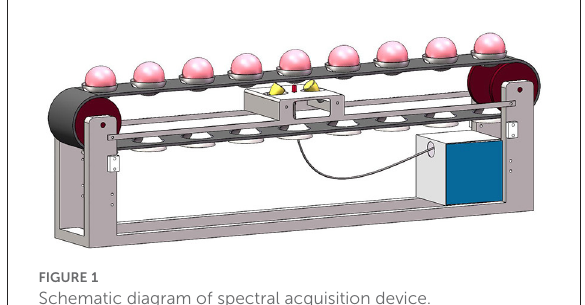
FIGURE1 Schematic diagram of spectral acquisition